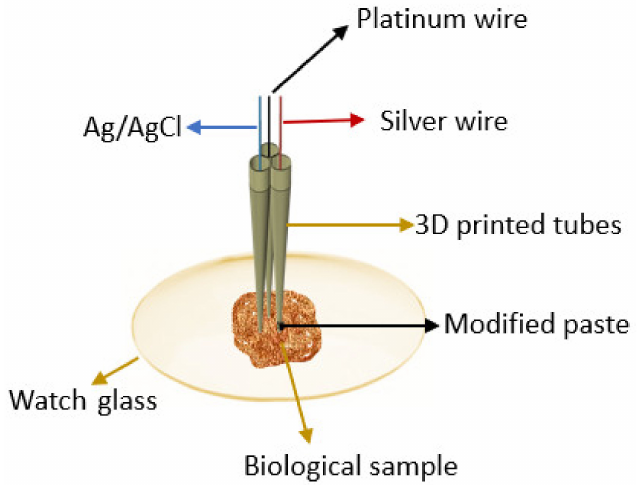
Figure 1. Experimental set-up.